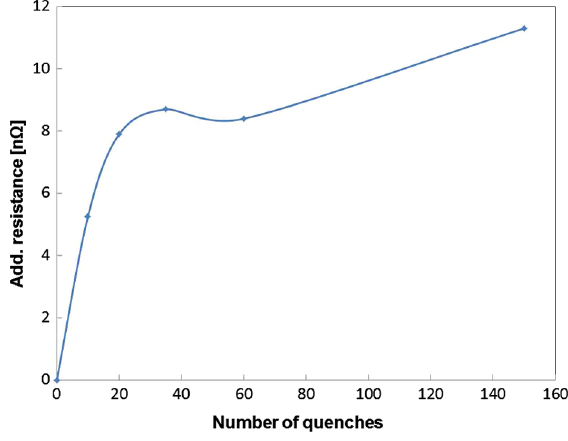
FIG. 41. Additional surface resistance after quenches in the cavity 1NC2 at ca 40 MV =